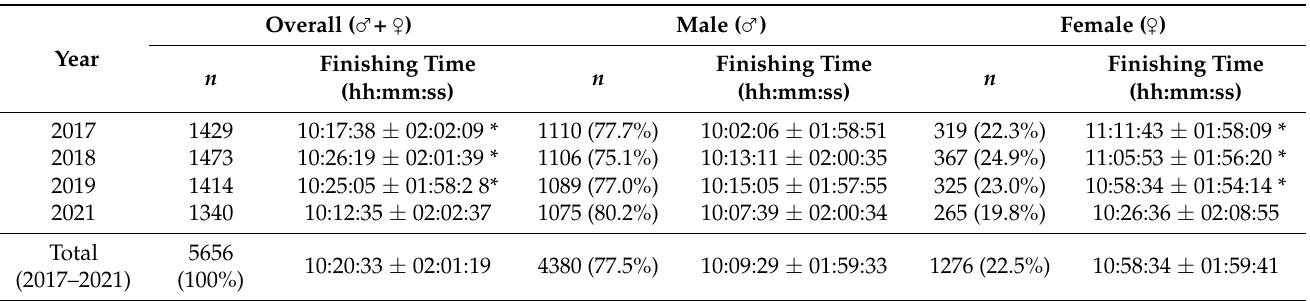
Table 1. Mean ± SD of finishing time and number of participants of the 2017, 2018, 2019, and 2021 OCC ®